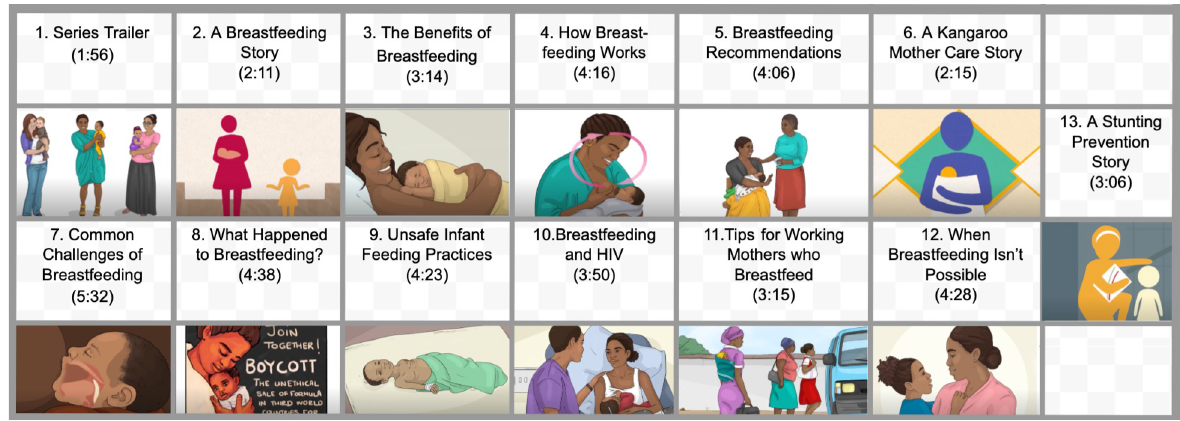
Fig 3. Philani MOVIE video topics and duration. Links to the videos used in the intervention can be found in the supporting information section ( S1 File) at the end of this manuscript. MOVIE, MObile Video Intervention for Exclusive breastfeeding.